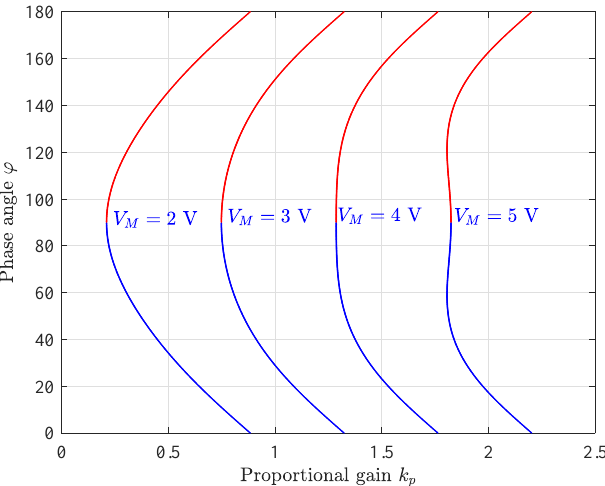
Figure 10. Critical phase angles in [ ◦ ] defining the SO interval in terms of the proportional gain k p for different values of the ramp amplitude V M